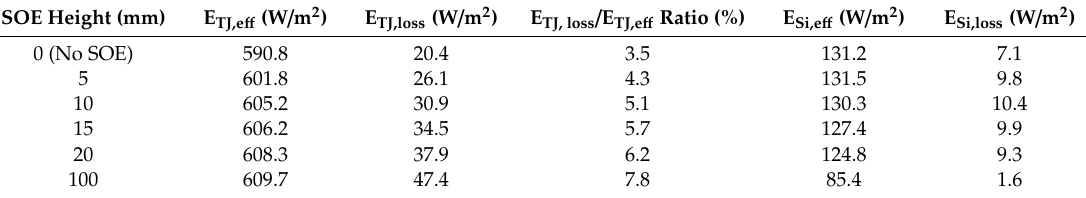
Figure 3. SOE designs with different mirror heights of ( a ) 0 mm (no SOE), ( b ) 5 mm, ( c ) 10 mm, ( d ) 15 mm, ( e ) 20 mm, and ( f ) 100 mm. Table 2. Irradiance on the triple-junction and silicon solar cells of the hybrid CPV module with different mirror heights, as calculated using TracePro. We again separated the results into the effective (0.3–1.299 μ m) and lossy (1.3–2.5 μ m) wavelength regions.